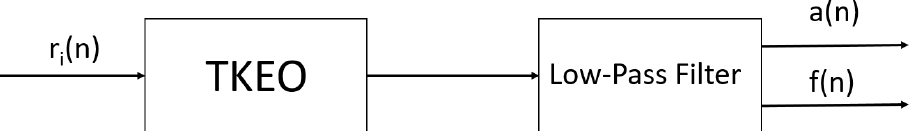
Figure 3. Block diagram of smoothing output of the energy